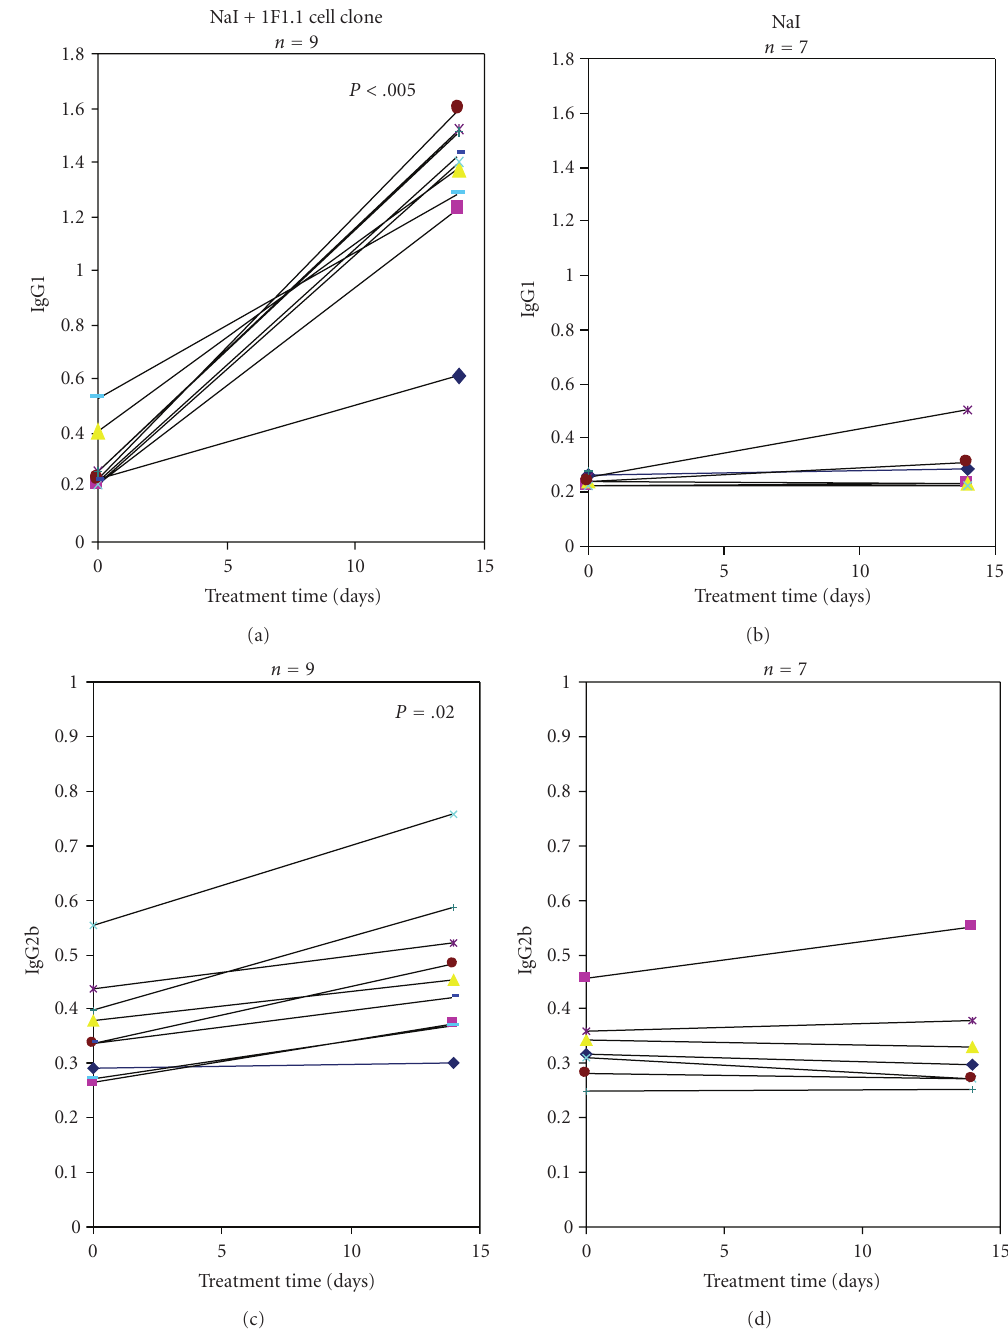
Figure 2: Adoptive transfer of iNKT line 1F1.1 in 8–10-week-old syngeneic mice induced antibodies to thyroglobulin. Mice in panels (a) and (c) received pretreatment of iodine and received iNKT cells. Both, IgG1 and IgG2b (a and c) antibody titers in the treatment groups (posttransfer day 14) were significantly higher as compared to the control group of mice (b and d). Shown IgG1 with P < . 005 and IgG2b with P = . 02. Control group mice on panels (b) and (d) received iodine pretreatment but no cells. No significant increase in the antibody titer to thyroglobulin was seen in control